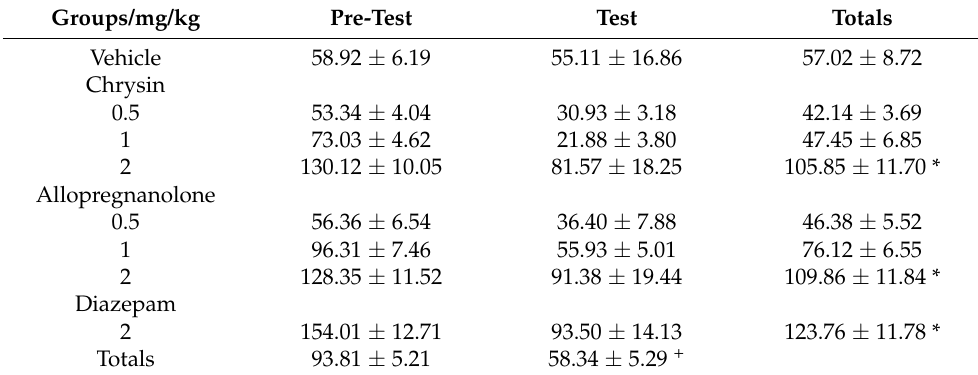
Table 2. Latency to the first immobility (s).